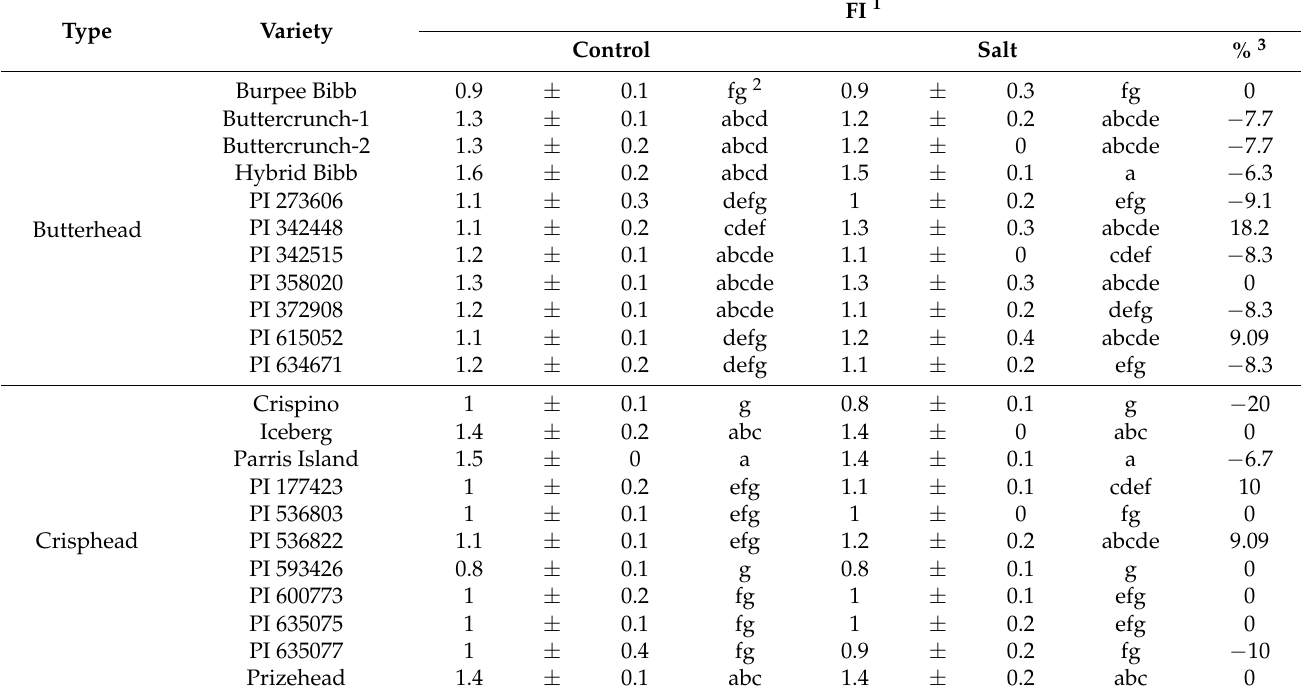
Table 9. Flavonoid index (FI) (mean ± standard deviation, n = 6) of butterhead- and crisphead-type lettuce cultivars grown under control and salt-stress conditions (100 mM) after 42 days of sowing (10 days after salt treatment).